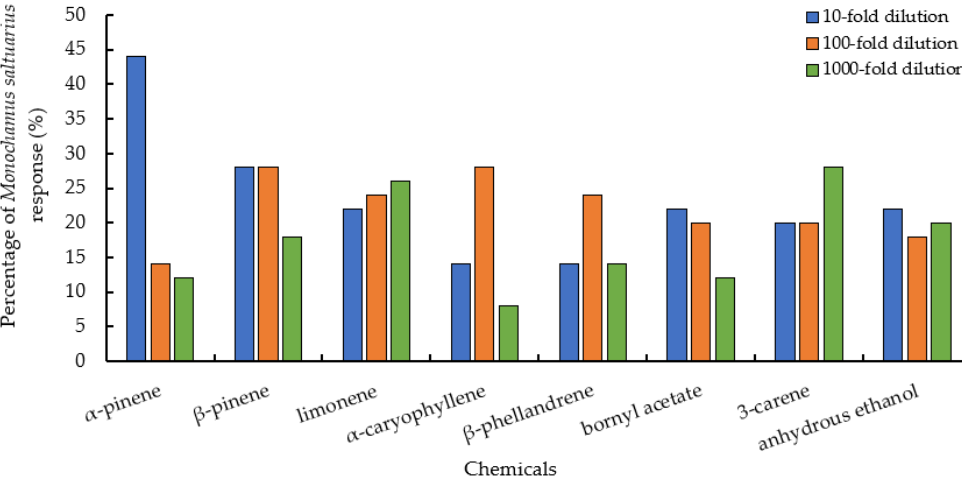
Figure 4. Response of Monochamus saltuarius to different concentrations of host pine tree volatiles .